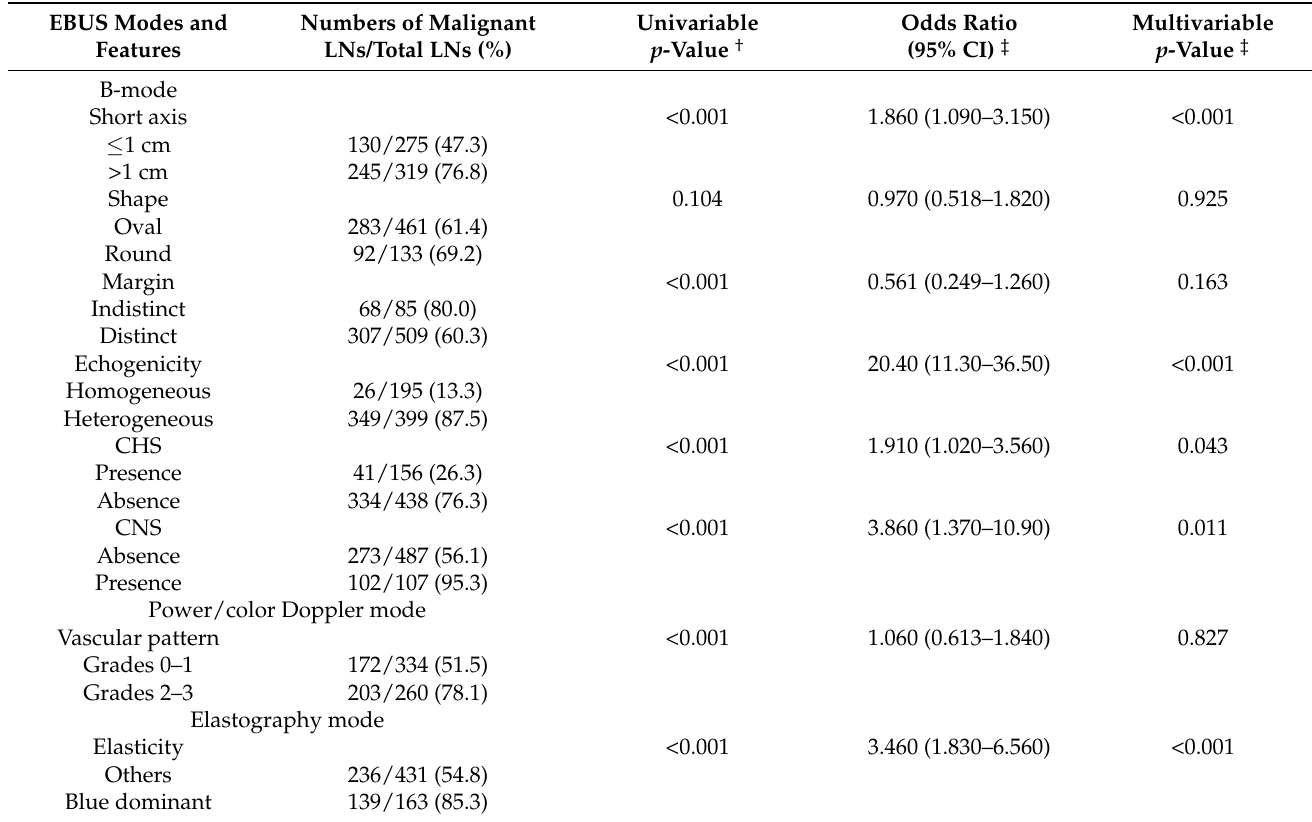
Table 3. Diagnostic yields of each EBUS feature for malignant lymph